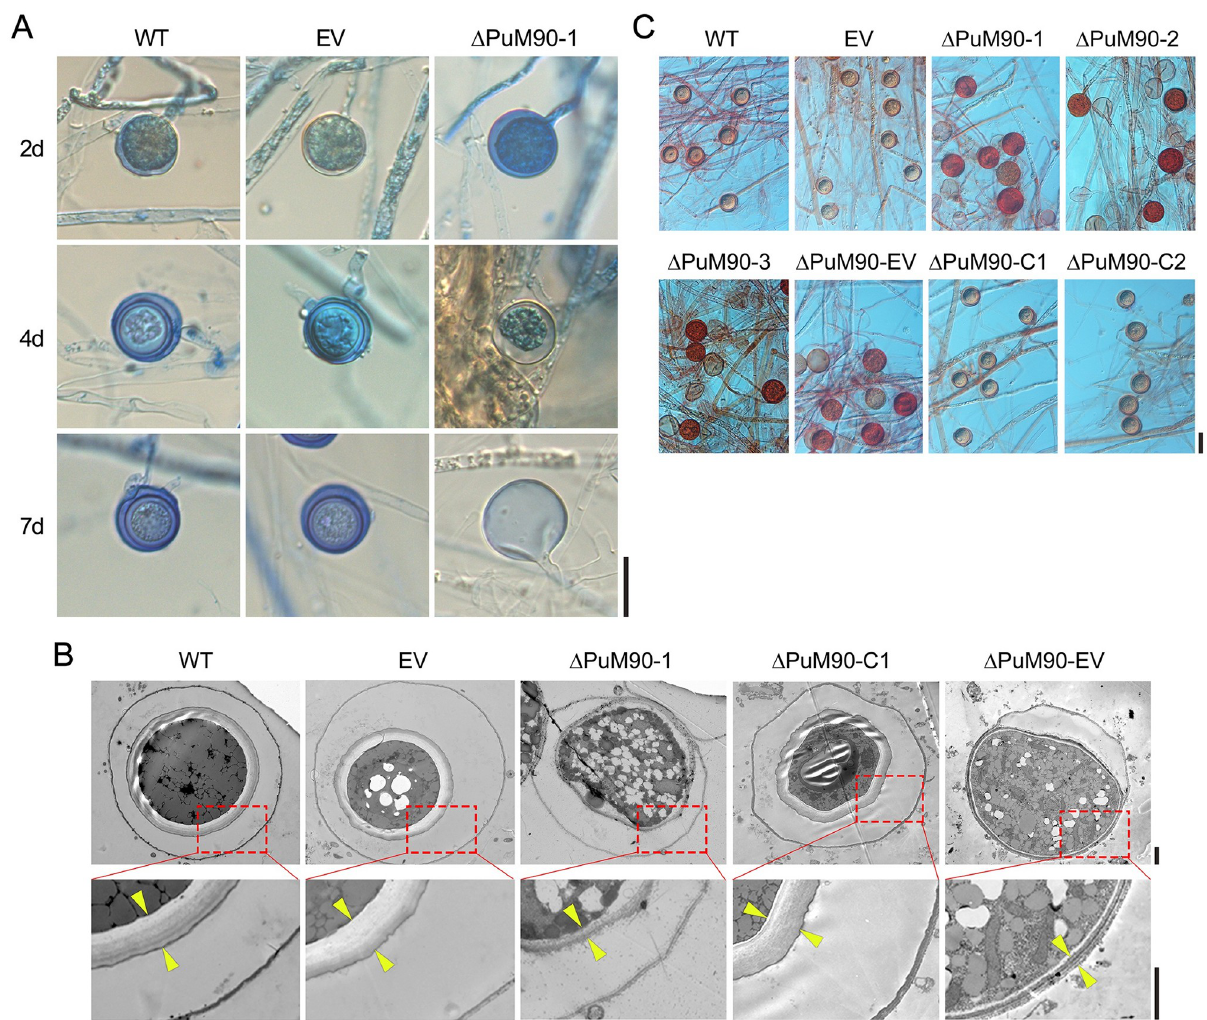
Fig 4. PuM90 -knockout transformants produce abnormal oospores. (A) Oospores from 2-, 4-, and 7-day-old cultures stained with lactophenol- trypan blue were observed under a light microscope. Bar, 20 μ m. (B) Oospores from 7-day-old cultures were observed with a transmission electron microscope (TEM). The area between the two yellow arrows represents the oospore wall. Bar, 2 μ m. (C) Oospores from 7-day-old cultures were observed with a light microscope after staining with 1000 ppm Congo red for 24 h. Bar, 20 μ